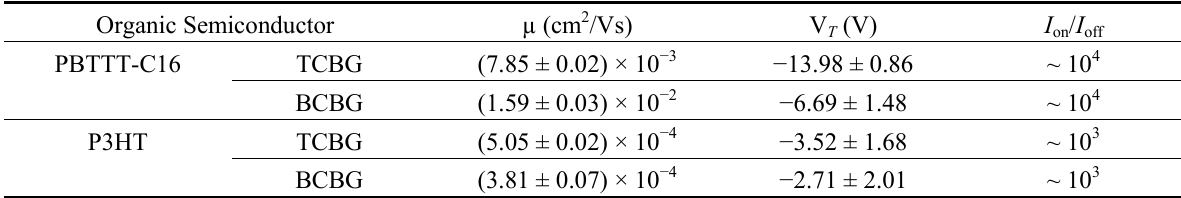
Table 1. Summarized electrical figures of merit for all OTFT devices as calculated from the I -V output characteristics. DS DS